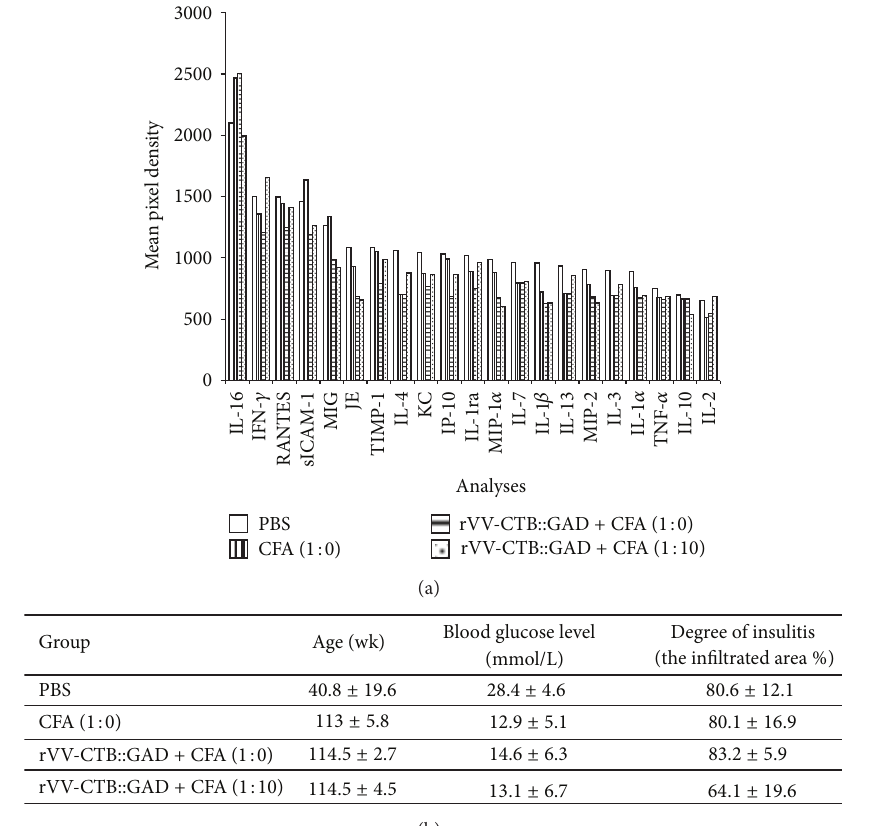
Figure 4: Analyses of secreted cytokines/chemokines. (a) Cytokines/chemikines synthesized by splenocytes of CFA (1:0), rVV-CTB::GAD + CFA (1: 0), and rVV-CTB::GAD + CFA (1:10) treatment group and naive (PBS) mice. (b) 4-5 mice from each experimental groups were euthanized and the synthesis of cytokines and chemokines in GAD-activated splenocytes was analysed. Means ± standard errors are shown for 4-5 mice/groups. Differences between ages of the treated groups of mice compared to PBS are statistically significant (one-way Anova, 𝑃 < 0.05 ). Differences between groups in blood glucose and data of percentage of insulitis are statistically insignificant (one-way Anova, 𝑃 > 0.05